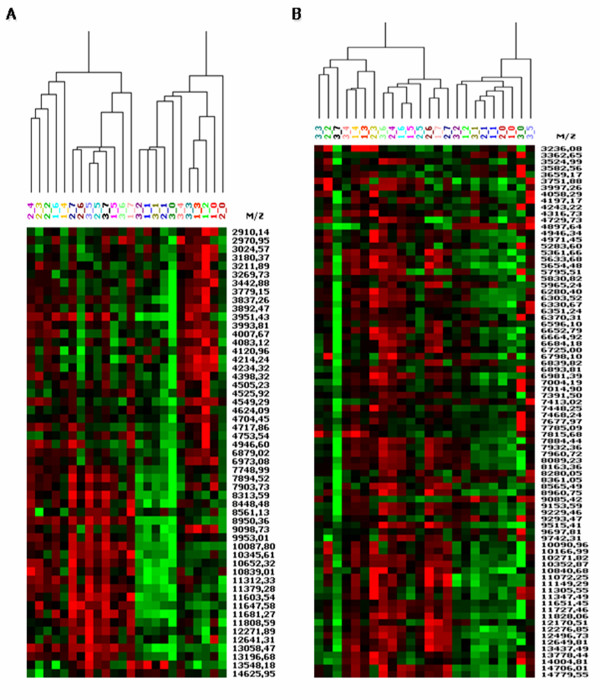
 Graphical representation of cluster analyses of SELDI-ToF mass spectrometry. Peaks detected in AD-MSC from different donors (1-2-3) during subculturing passages (from 0 to 7) indicated as donor_passage for A) cytoplasmic and B) nuclear enriched fraction. Red color intensity, high expressed; green color intensity, low expressed.